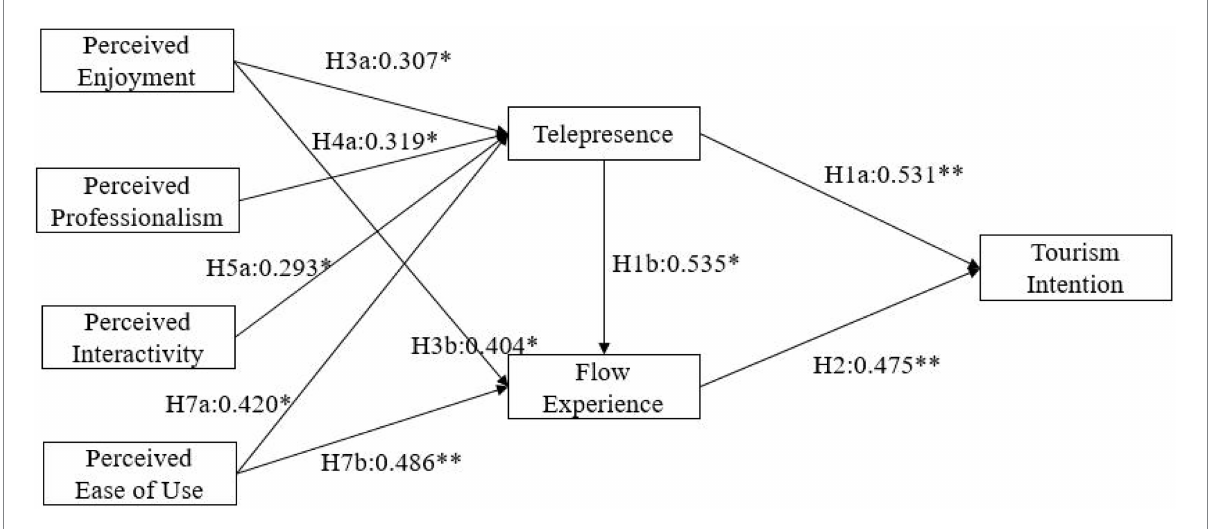
FIGURE 2 Model path verification. * p < 0.05; ** p <